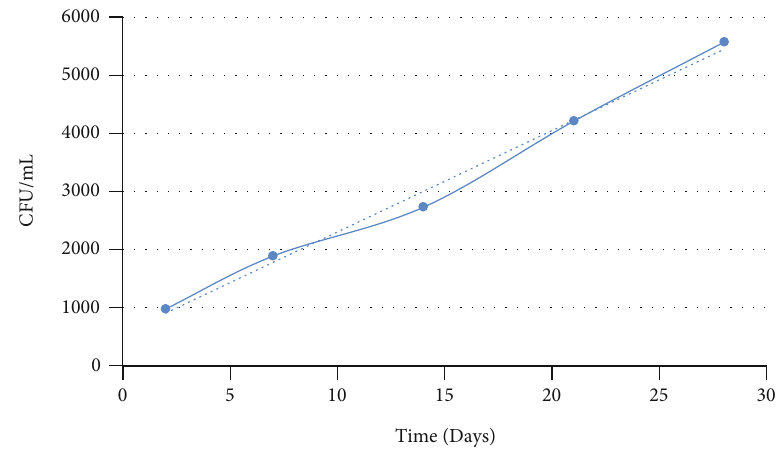
Figure 1: Colony count for Bacillus megaterium immobilized onto recycled mortar.